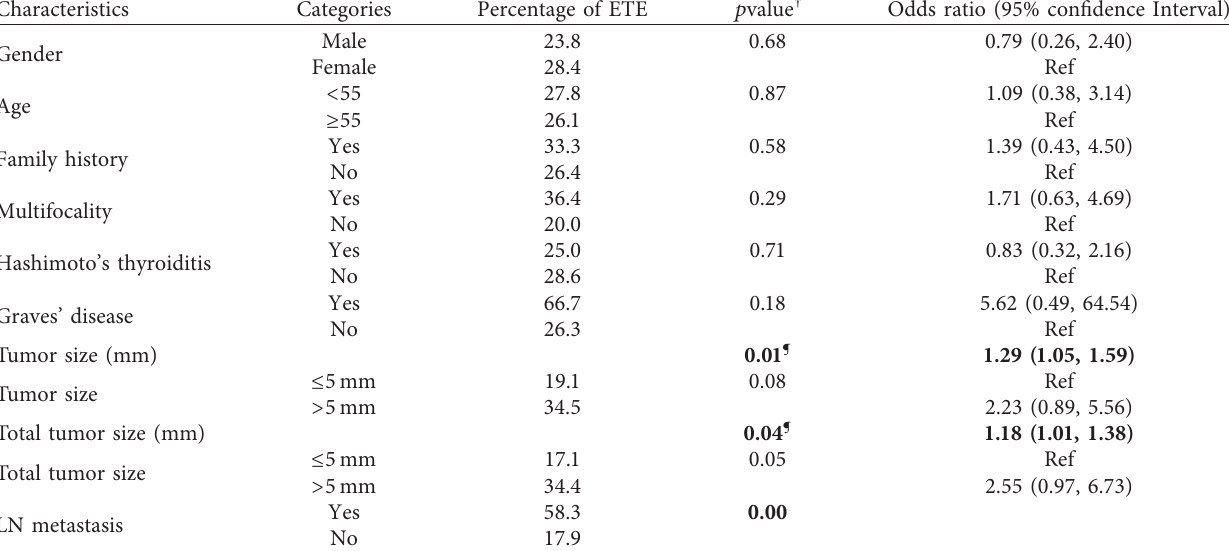
Table 5: Association between different characteristics and ETE.